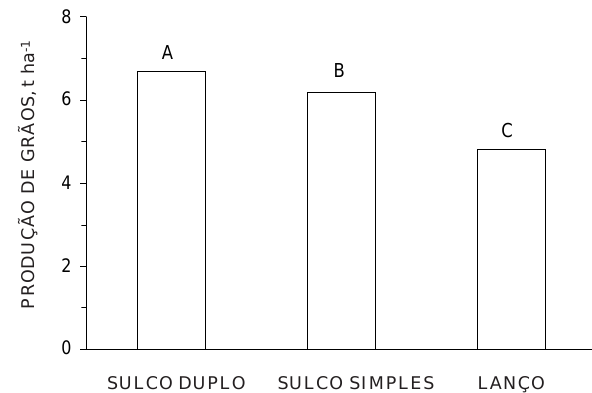
Figura 1. Efeito dos modos de aplicação do fertilizante fosfatado em sulco duplo, sulco simples e a lanço na produção de grãos da cultura do milho (dados médios de seis doses de fósforo e quatro repetições). Colunas com a mesma letra não diferem estatisticamente entre si pelo teste de Tukey (P < 0,05).